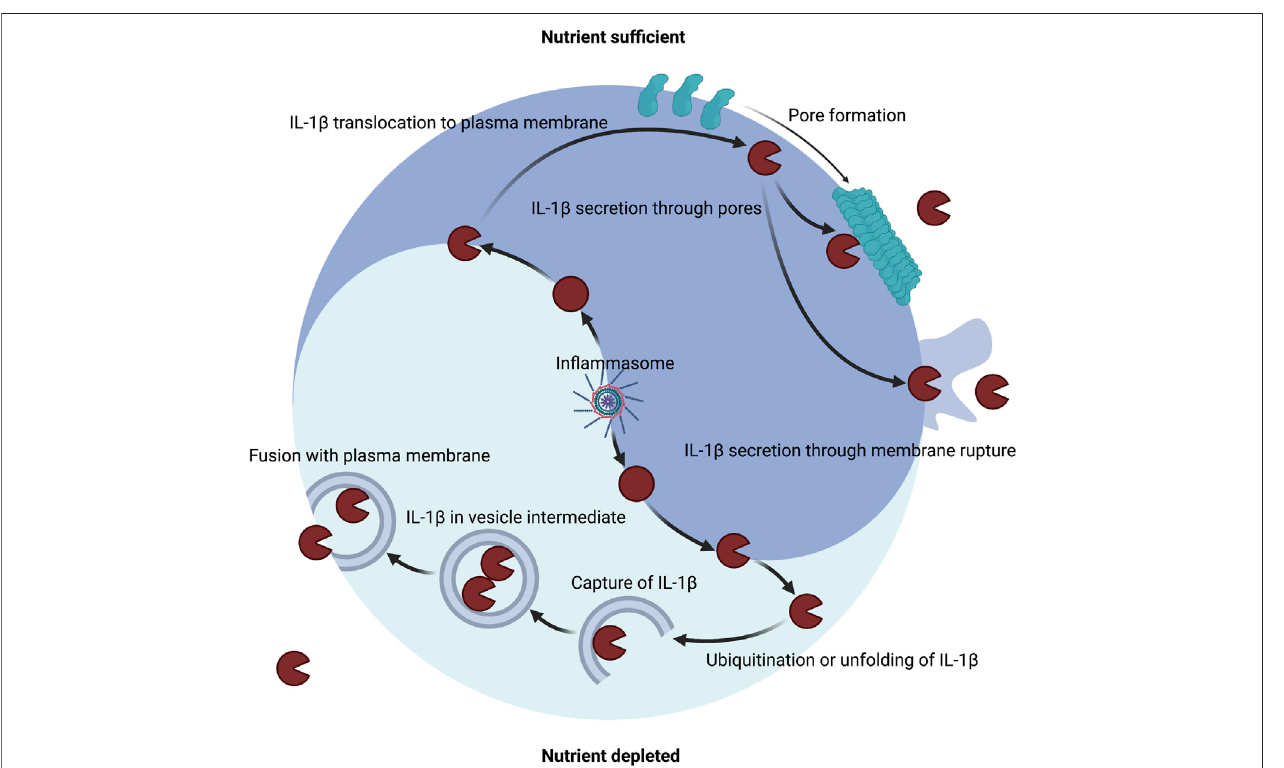
FIGURE 3 | Host metabolic state dictates the route of IL-1 β secretion. A major mechanism of IL-1 β secretion involves permeabilization of the plasma membrane. In fl ammasomes can control the maturation of pro-IL-1 β into IL-1 β in both nutrient replete or nutrient depleted settings. In fl ammasomes can release the pore-forming moiety of GSDMD to encourage membrane permeability for direct secretion and can induce membrane rupture for indirect secretion. Several other membrane permeabilization strategiesaresuf fi cient tosecreteIL-1 β including othergasderminfamily members,necroptotic MLKL, bacterialpore formingtoxins,and physical disruption. An alternate mechanism of IL-1 β secretion may exist that involves capture or translocation into a vesicle intermediate during nutrient depleted or proteotoxic stress settings.